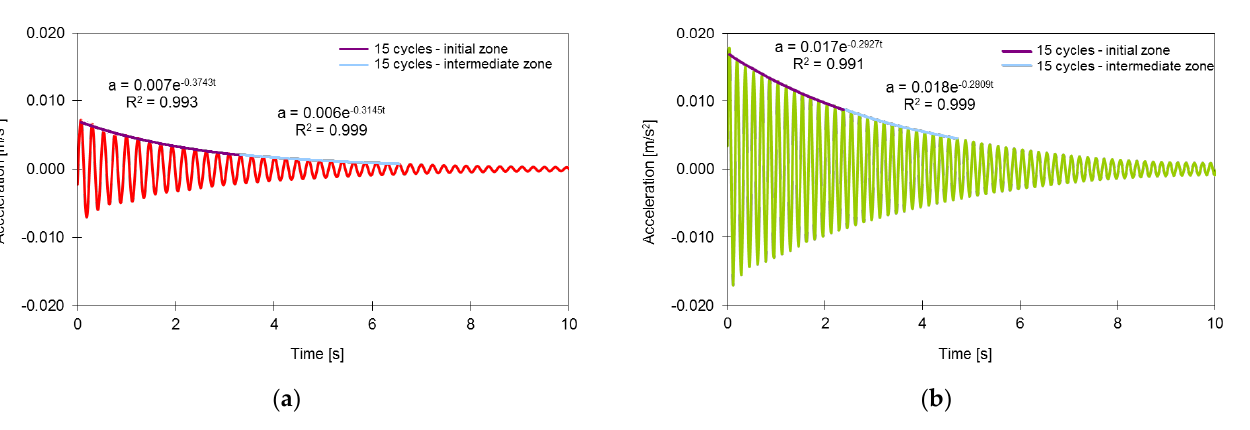
Figure 18. Application of the logarithmic decrement method to the AP150 train acceleration record, in estimating the damping ratios: ( a ) mode 2; ( b ) mode 3.